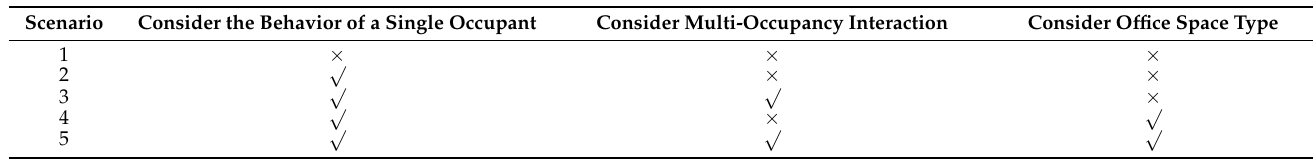
Table 10. Considerations for scenario setting.